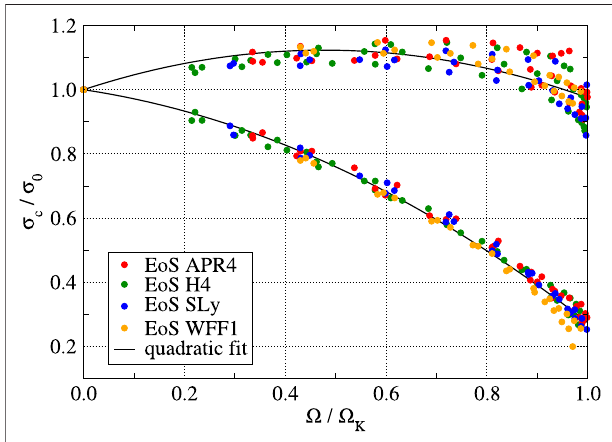
FIGURE 2 | Universal relations for the l (cid:1) | m | (cid:1) 2 f -mode frequencies for sequences of constant baryon mass as observed in the comoving frame. The graph shows the results from 12 such sequences (three sequences per EoS). The stable f -mode branch displays universal behavior. Figure taken from Krüger and Kokkotas (2020a) with permission by